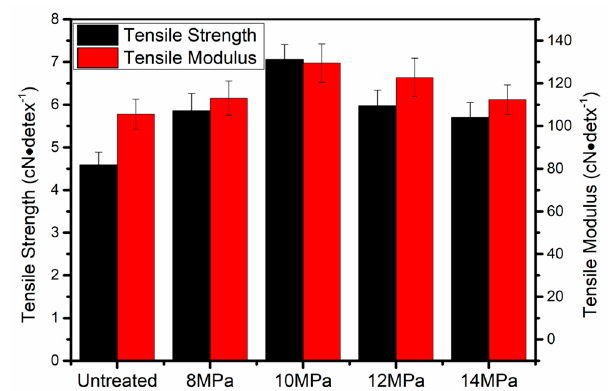
Figure 2. Mechanical performance of PAN fibers treated at different pressures in supercritical carbon dioxide (Sc ‐ CO 2